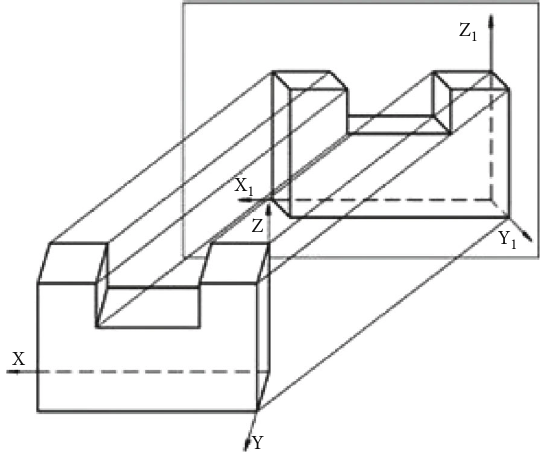
Figure 2: Oblique axonometric